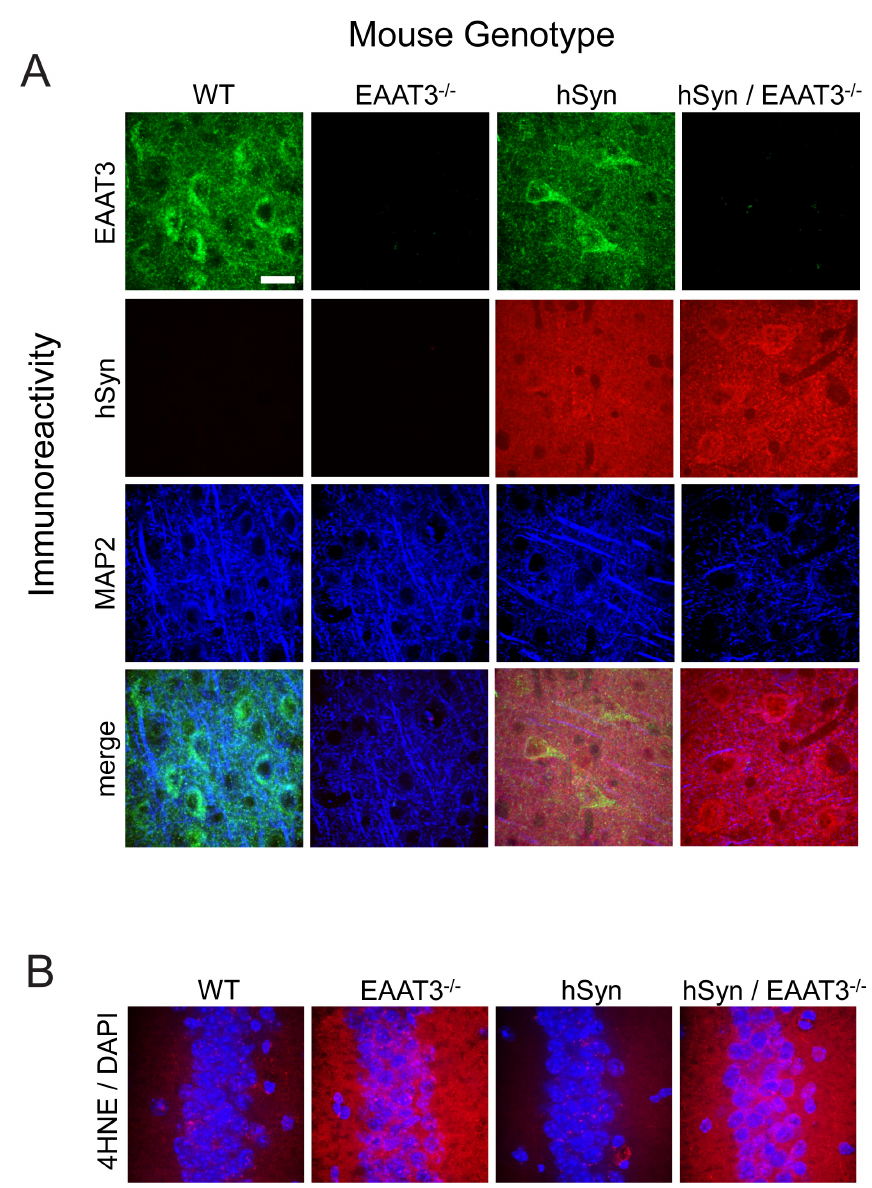
Figure 1. Expression of EAAT3 and human α -synuclein in the wild-type and transgenic mouse strains. ( A ) Mouse cerebral cortex immunostained for excitatory amino acid transporter-3 (EAAT3, green), human α -synuclein (hSyn, red), and the neuronal marker microtubule-associated protein-2 (MAP2; blue). The mouse strains are wild-type (WT); EAAT3 − / − ; line 61 Thy-1-hSyn (hSyn); and hSyn/EAAT3 − / − . ( B ) Immunostaining for 4-hydroxynonenal (4HNE; red) in the hippocampal CA1 neuronal layer shows increased signal in the EAAT3 − / − and hSyn/EAAT3 − / − mice. Nuclei are stained blue with DAPI. All images are representative of n = 4 mice. Scale bar = 20 µ